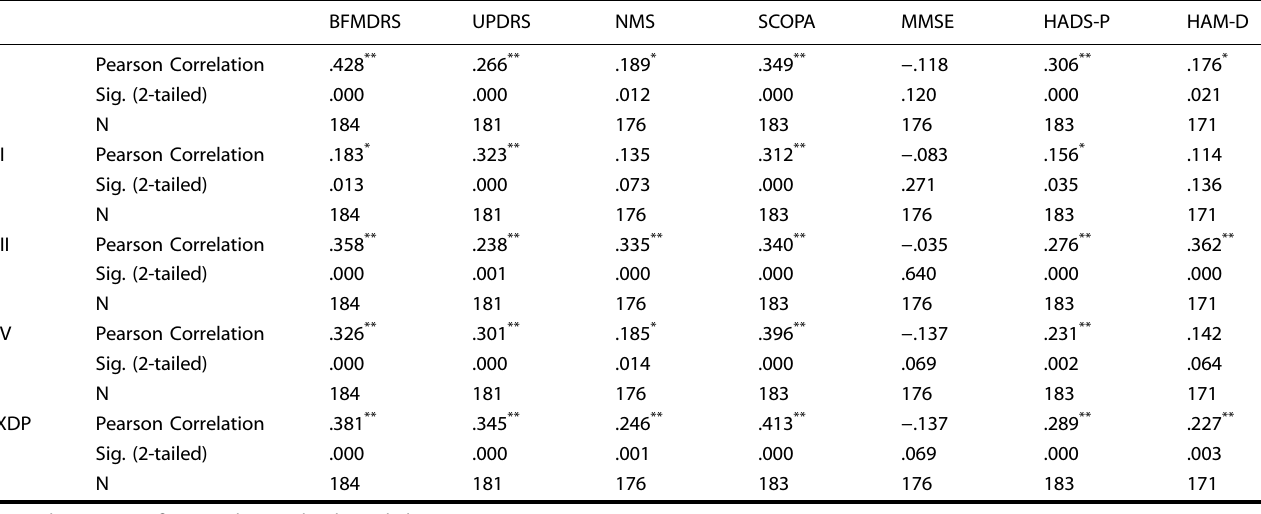
Table 2. Determination of convergent validity via correlation of the different domains of the XDP – MDSP scale with various external scales (I with BFMDRS, II with UPDRS motor, III with NMSQuest and IV with SCOPA) and correlation with HADS-P, HAMD and